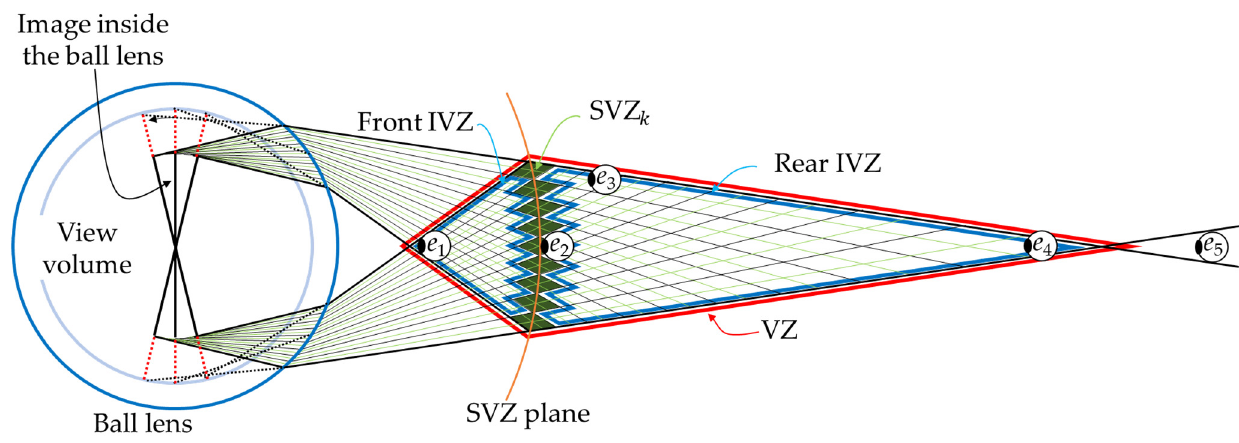
Figure 4. Front and rear integrated view zones (IVZs) for integrated view and SVZs for individual views.